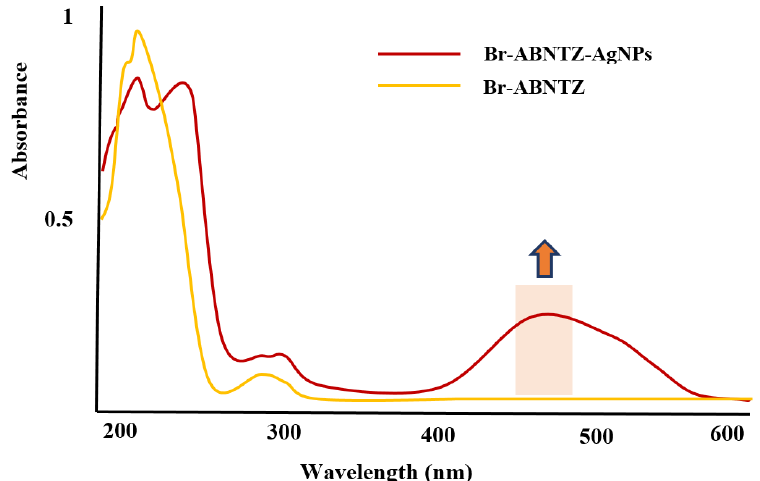
Figure 2. Representative UV-vis spectra of functionalized 2-amino-6-bromobenzothiazole–AgNPs ( 5-np ) (shown in red) with the corresponding organic ligand 5 (shown in yellow). The nanoconjugate displayed a characteristic SPR band maximum within the typical range of 380 – 480 nm.